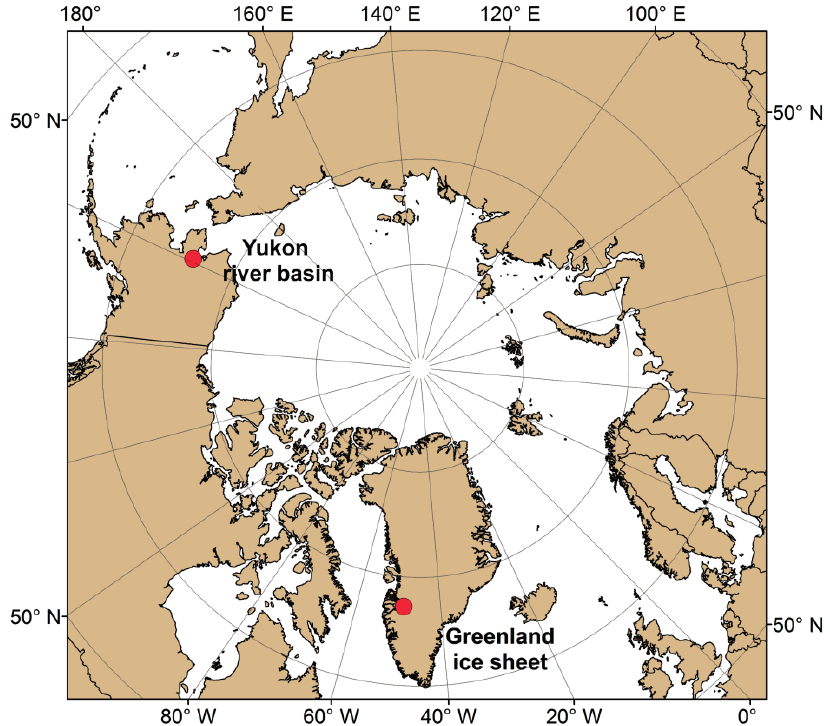
Figure 9. Study area map. The Yukon River Basin and the Greenland Ice Sheet are selected as study areas. Both areas are located in the Arctic. River networks distributed in these two areas are well developed and thus ideal for river detection experiments.